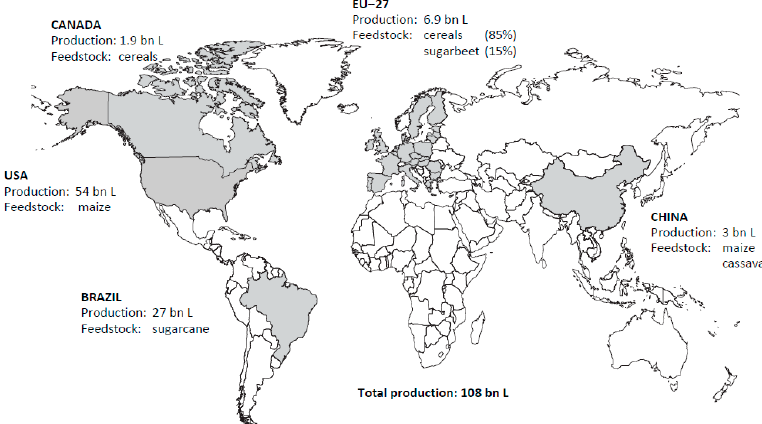
Figure 2. Word fuel ethanol production, average 2012–2014 [5].